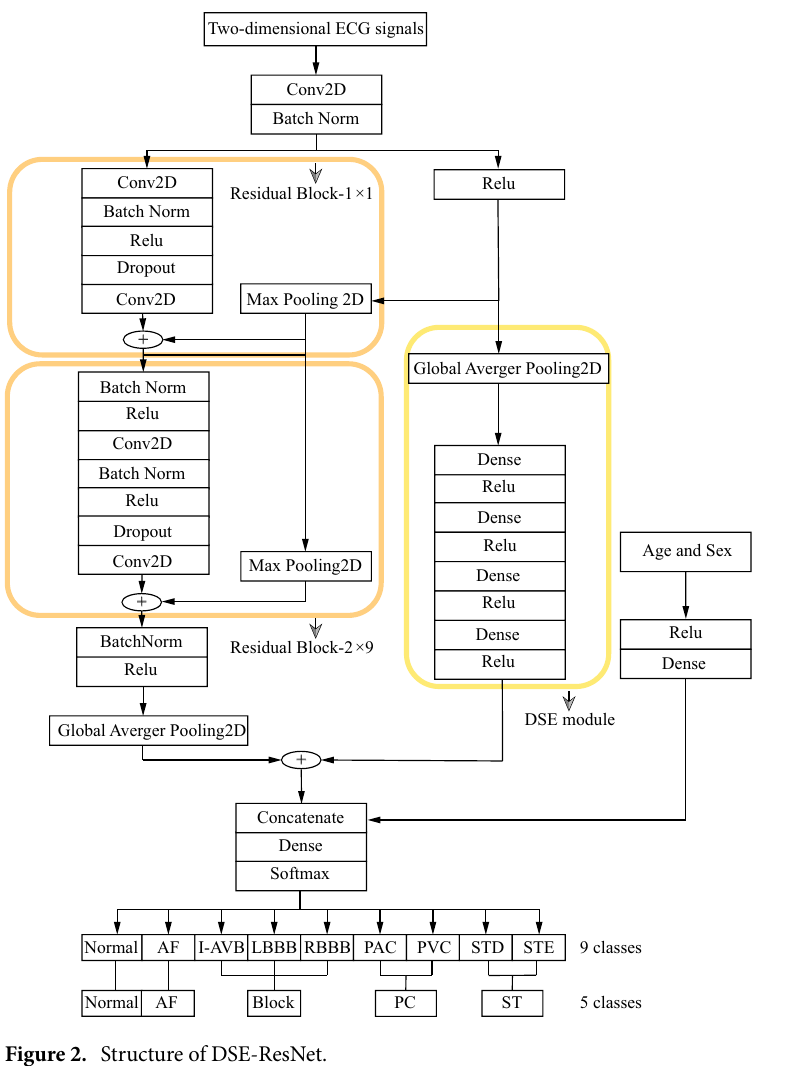
Figure 2. Structure of